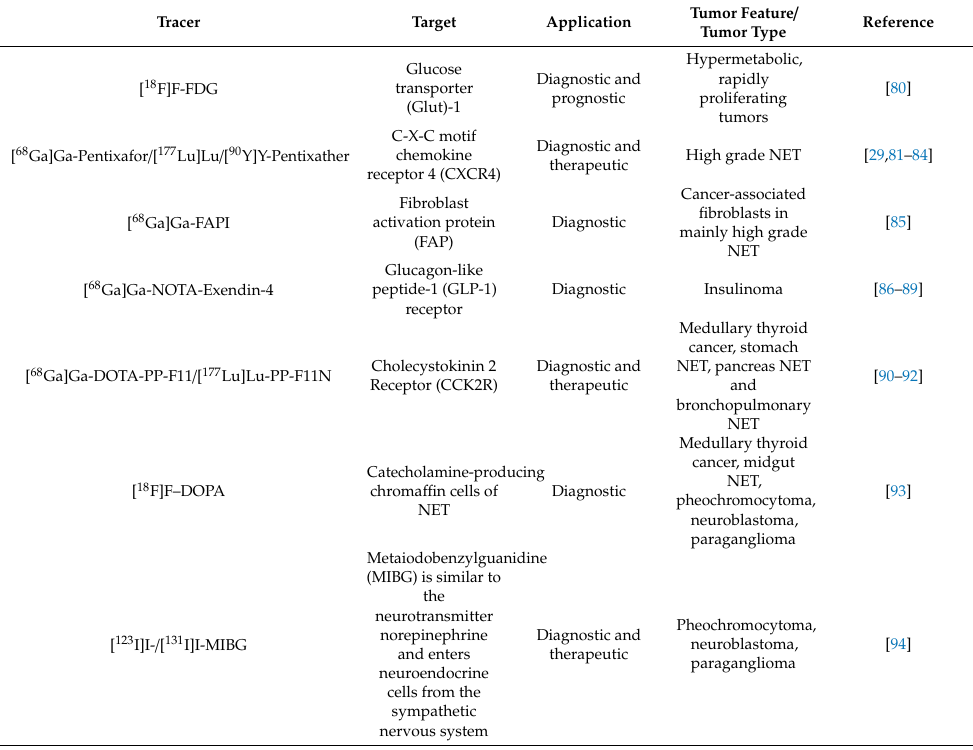
Table 3. Potential targets for molecular imaging and treatment in somatostatin receptors (SSTR)-negative neuroendocrine tumors